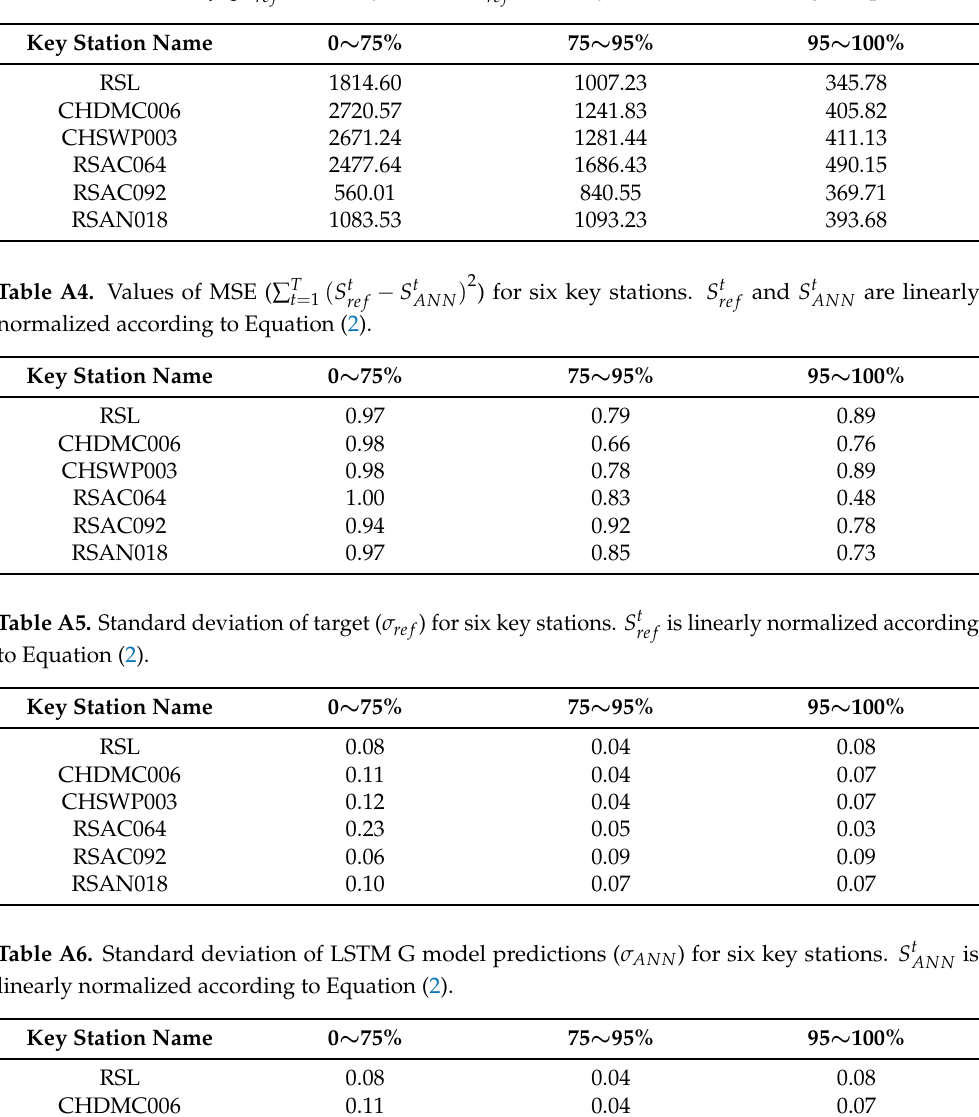
is linearly normalized according to Equation (2). ref